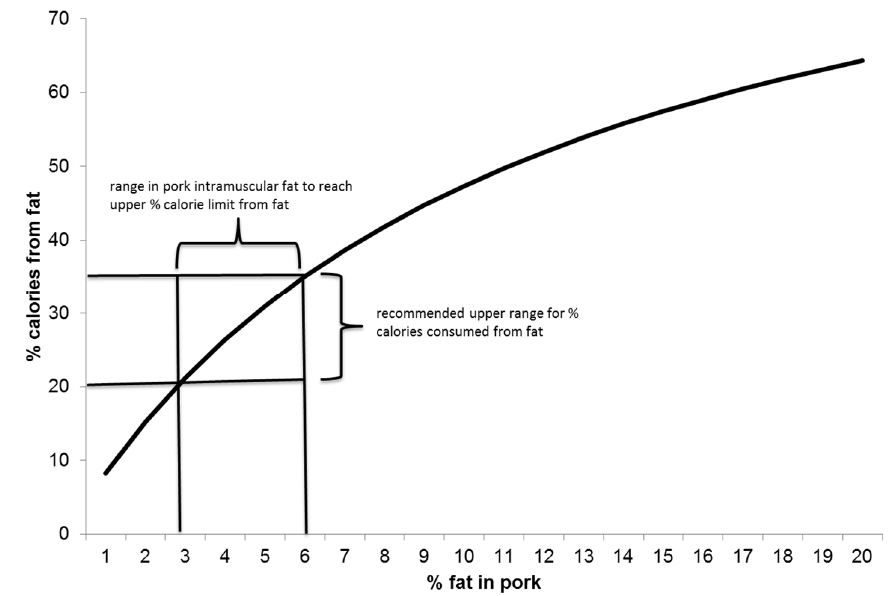
Figure 1. Calories in pork fat relative to recommendations for fat consumption.